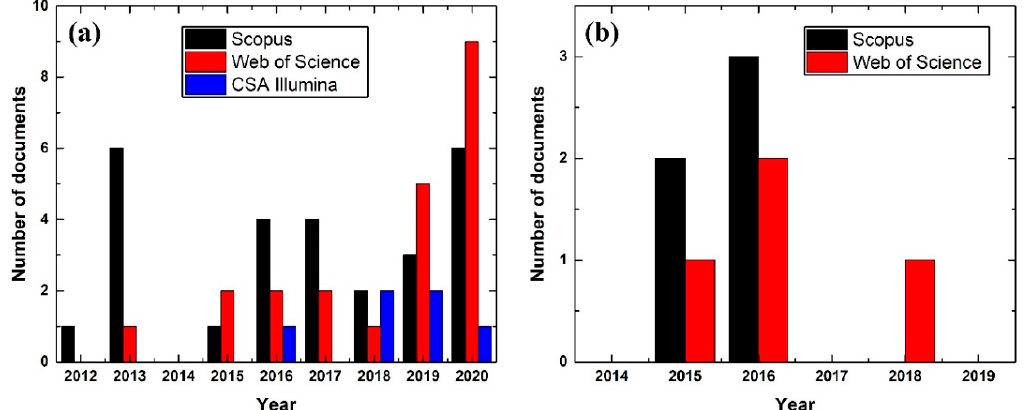
Figure 1. Search results obtained from Scopus, Web of Science, and CSA Illumina databases, where ( a ) shows the number of documents that were published from 2012–2020 with the term ‘Gas turbine nanofluid’ [7,9,10], and ( b ) demonstrates those containing the phrase ‘Intercooler nanofluid’ [8,11].